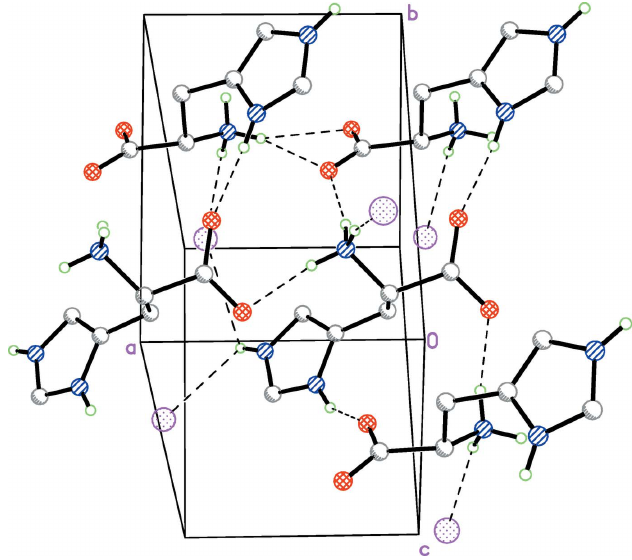
Figure 2 Packing diagram of the title compound. Hydrogen bonds are shown as dashed lines. H atoms bonded to C atoms have been omitted for clarity.